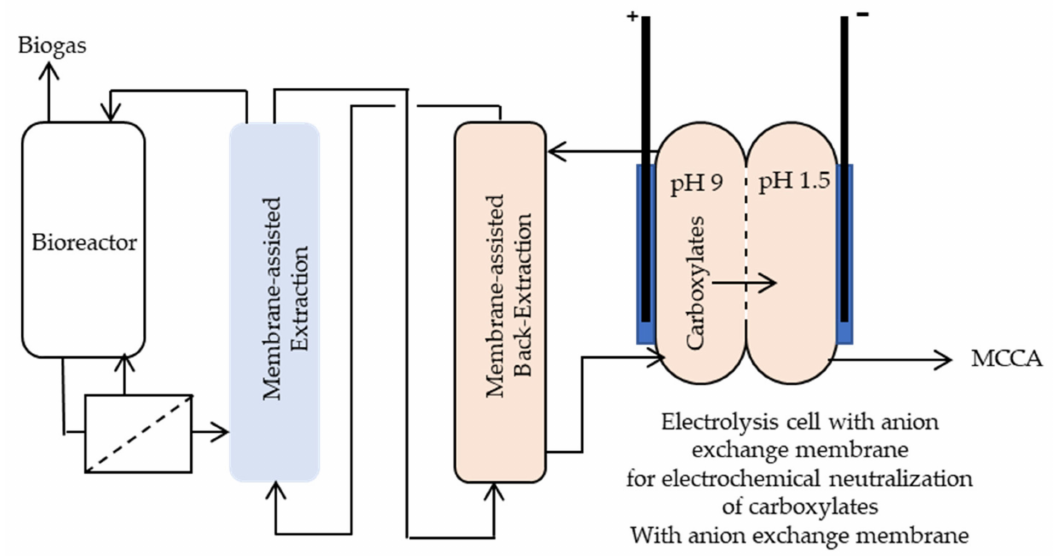
Figure 6. Schematics of the bioreactor and product separation system comprised of membrane- assisted extraction and back-extraction and a membrane electrolysis cell as described in